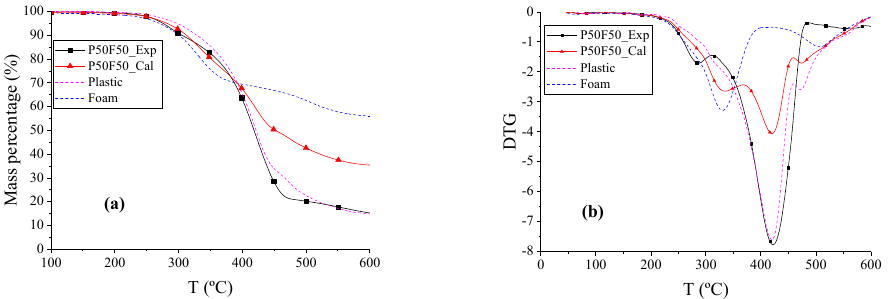
Figure 6. The TG and DTG thermograms of P, F, and P50F50. ( a ) TG thermograms reflects the change of mass percentage during pyrolysis process. ( b ) DTG thermograms refers to the derivative curves of TG thermograms.